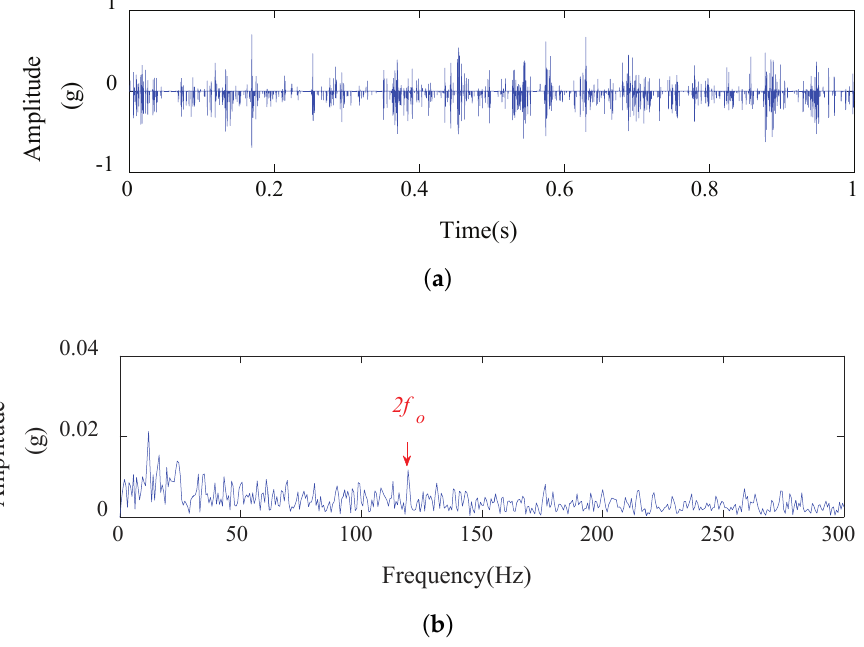
Figure 24. Results of soft threshold: ( a ) Time domain waveform. ( b ) Envelope